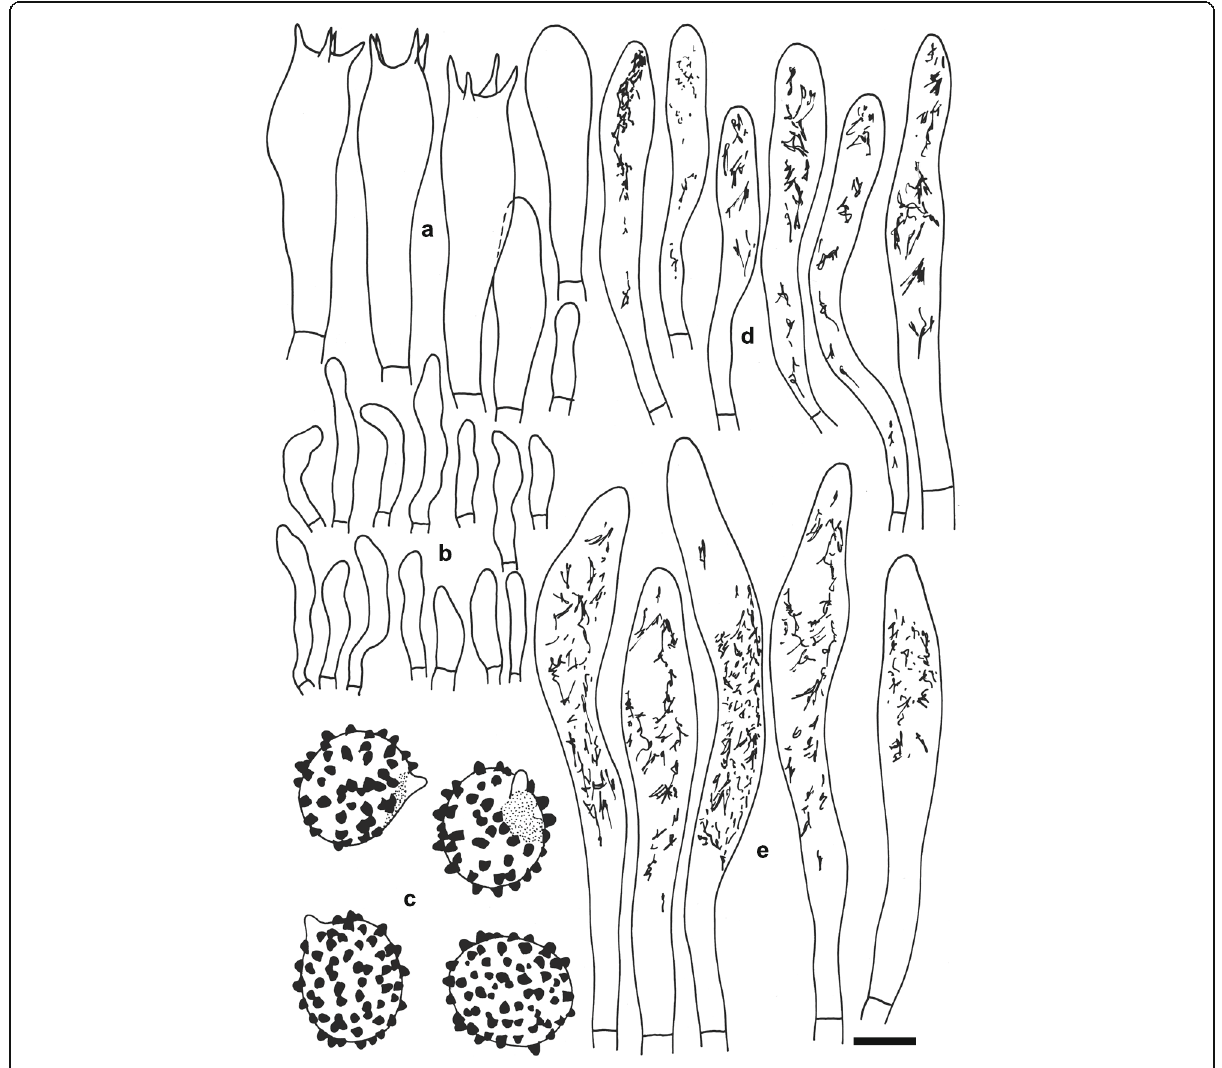
Fig. 4 Russula dryadicola (IB 1997/0750, neotype). Microscopic features of the hymenium. a. Basidia and basidiola. b. Marginal cells. c. Basidiospores in Melzer ’ s reagent. d. Cheilocystidia. e. Pleurocystidia. Contents of cystidia are represented as observed in Congo red. Bars = 10 μ m, spores = 5 μ m. Drawings: S.A. &